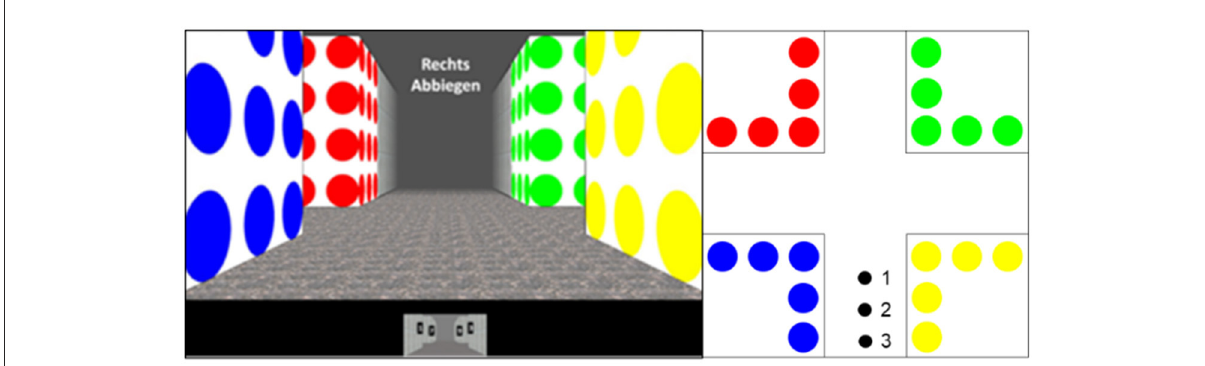
FIGURE7 (Left) An example of an intersection in the virtual environment of Experiment 3. (Right) Illustration of the three distances “near” (1), “medium far” (2), and “far” (3). The participants were (virtually) standing at one of the three positions. The simulated distances from the intersection were about 1.5 meters for “near” (1), 2.5 meters for ‘medium far’ (2) and 3.5 meters for “far”